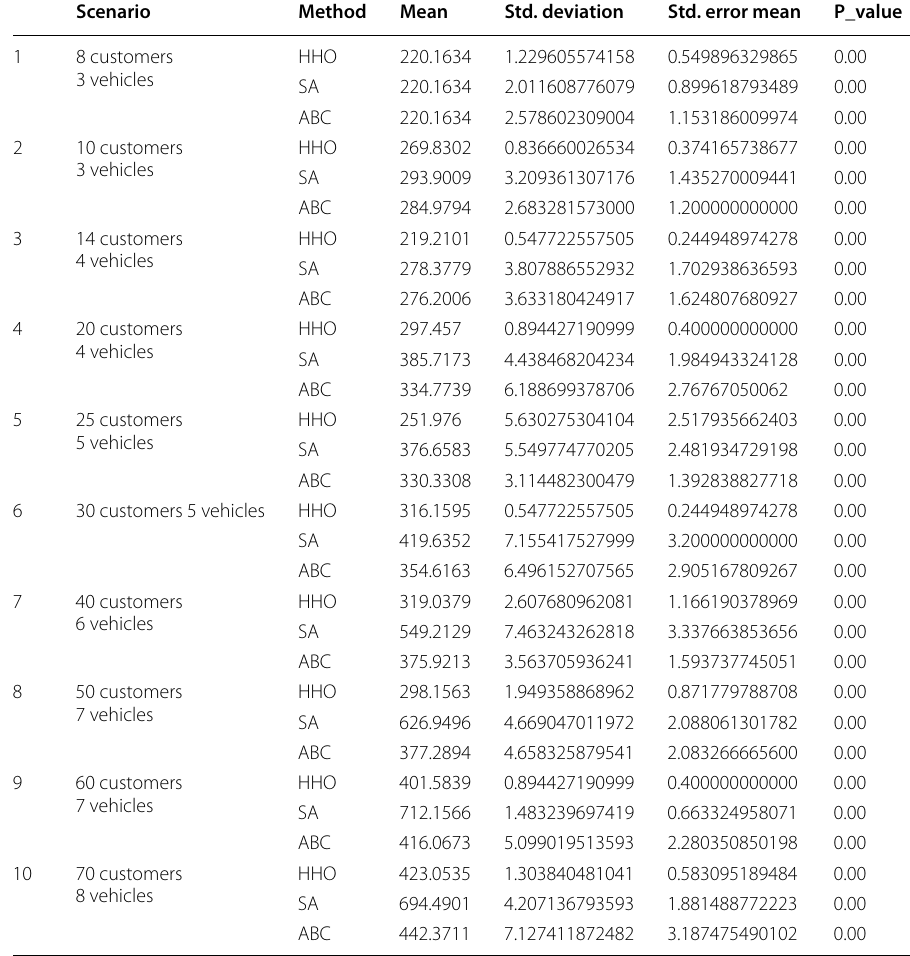
Table 4 T-test results for HHO, SA and